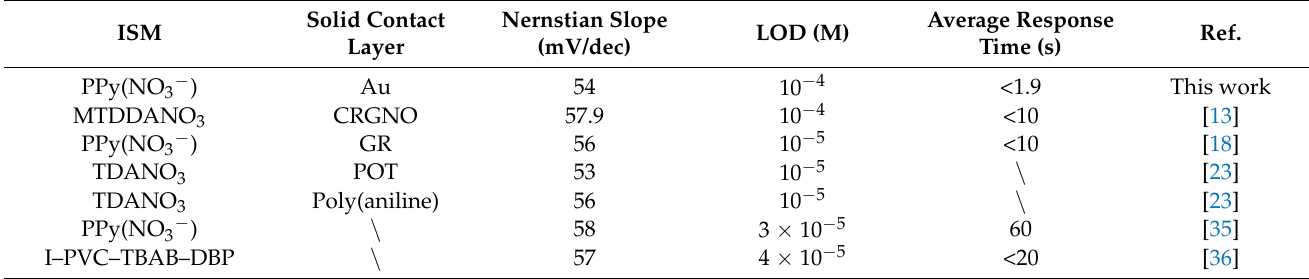
Table 1. Comparison of nitrate-selective all-solid-state electrodes.